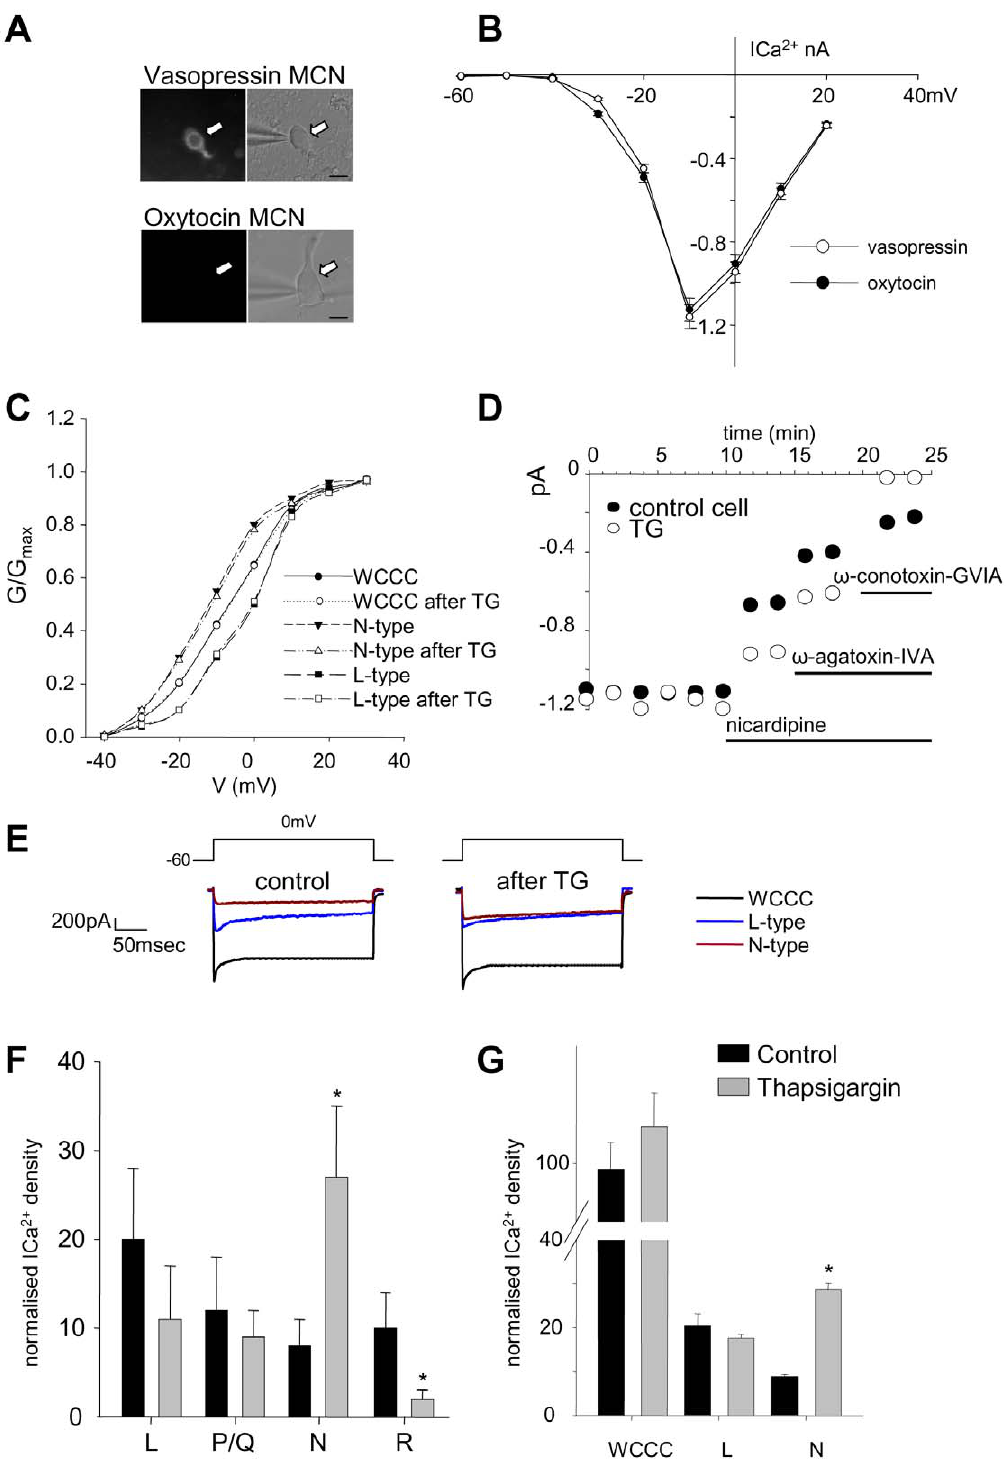
Figure 5. Effects of channel toxins on Ca 2 + currents in isolated SON neurons. ( A ) Isolated magnocellular neurons were identified as either vasopressin or oxytocin by their presence or absence of the GFP signal. Scale bar=10 m m. ( B ) The current-voltage relationships show no difference between whole-cell calcium currents (WCCC) of vasopressin and oxytocin neurons (n=20 each). ( C ) Normalized conductance (G/G max , fitted using Boltzmann equation) showed no significant change with or without TG. ( D ) Examples of two neurons (both oxytocin neurons), one vehicle treated ( and one 50 min after pre-treating with thapsigargin ( # ). The steady-state Ca 2 + current is plotted against time following treatment with channel toxins (in order: 1 m M nicardipine; 200 nM v -agatoxin IV; 500 nM v -conotoxin GVIA). The current measured after each toxin was subtracted from that evoked before each treatment to determine the current carried by L-, P/Q- and N-type channels. The remaining current was attributed to R-type channels. ( E ) Examples of N-, L- and WCCC elicited by voltage steps in controls and TG treated cells. ( F ) The resulting current density for each current type normalised for the peak maximal current was averaged (n=5) to give the average current density from neurons treated with vehicle or